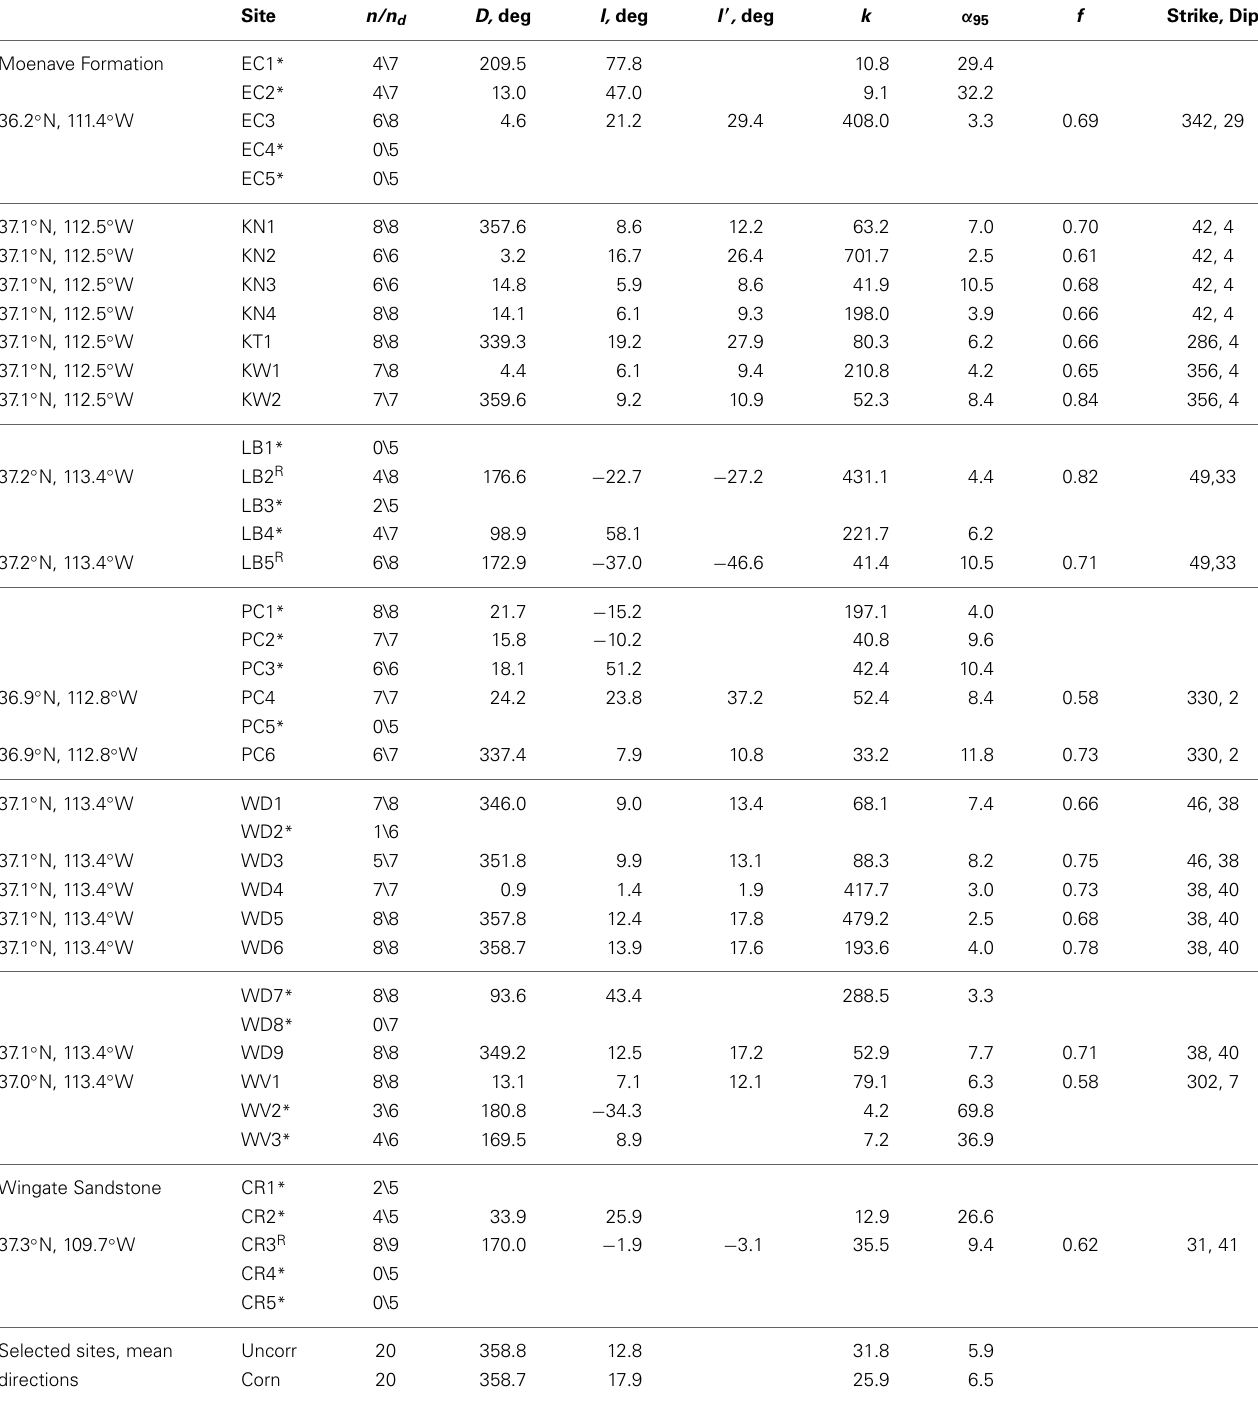
Table 1 | Paleomagnetic data and statistical